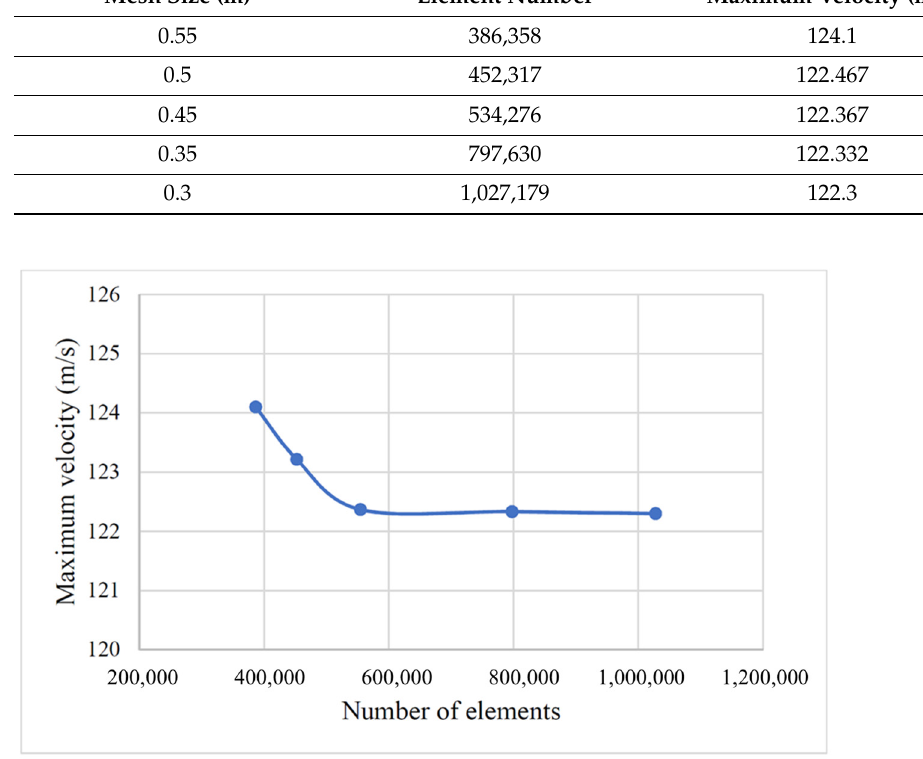
Figure 7. Mesh sensitivity analysis of five different mesh sizes for the fluid domain.